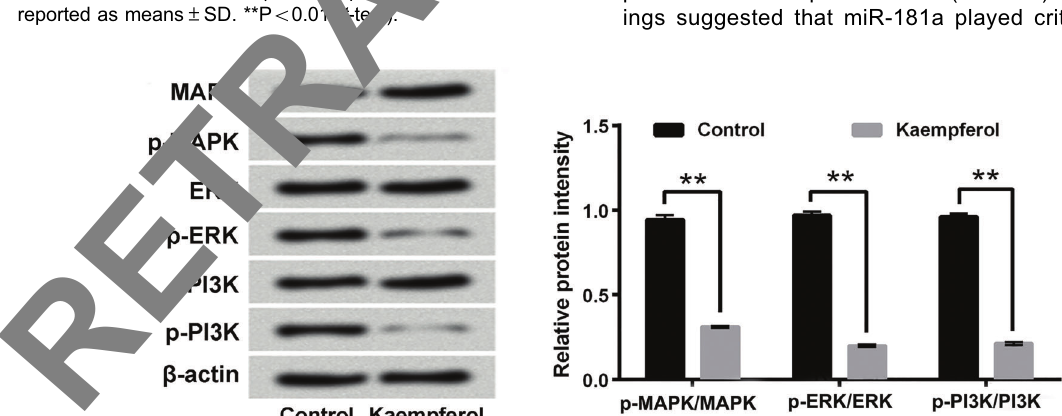
Figure 6. Kaempferol inactivated MAPK/ERK and PI3K pathways in SNU-216 cells. After 50 m M kaempferol treatment, the expressions of MAPK, p-MAPK, ERK, p-ERK, PI3K, and p-PI3K in SNU-216 cells were determined using western blotting. MAPK: mitogen-activated protein kinase; ERK: extracellular regulated protein kinases; PI3K: phosphatidylinositol 3 kinase. Data are reported as means ± SD. **P o 0.01 ( t